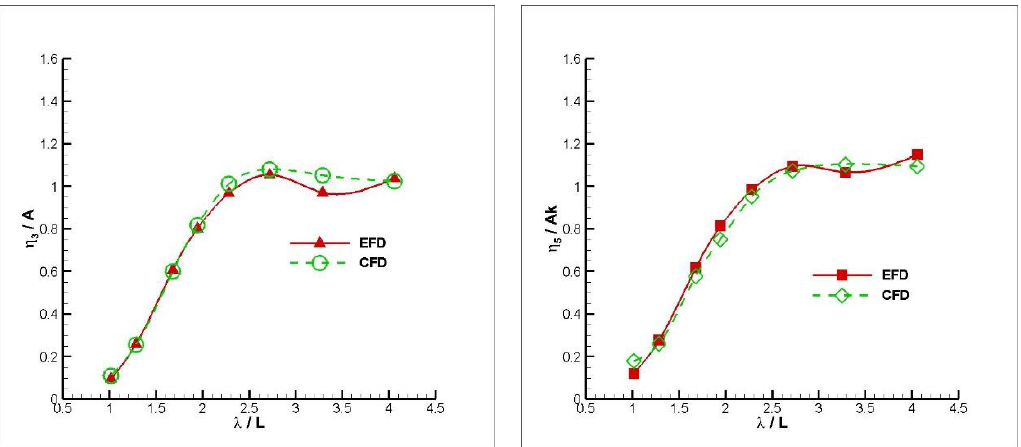
Figure 6. Heave ( left ) and Pitch ( right ) RAOs of the mono hull at Fn B = 1.67.